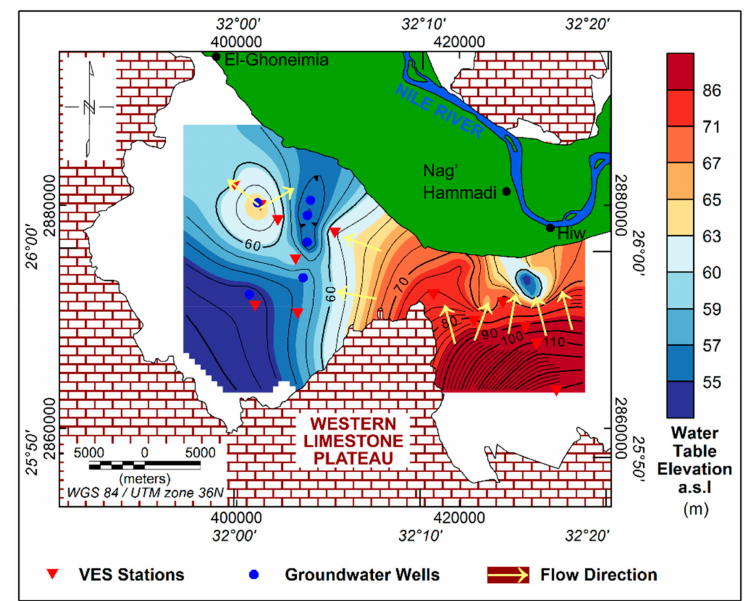
Figure 20. Water-table elevation inferred from VES